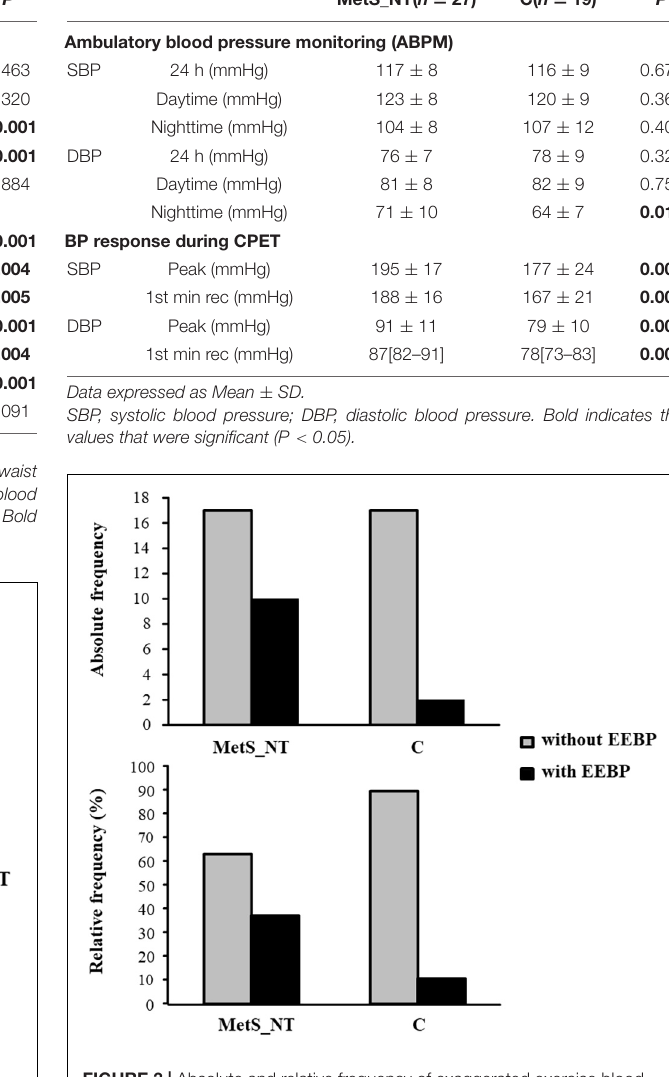
FIGURE 3 | Absolute and relative frequency of exaggerated exercise blood pressure (EEBP = peak exercise SBP ≥ 210 mmHg in men and ≥ 190 mmHg in women) response during maximal CPET in the MetS_NT and in C. Note that the prevalence was significantly lower in the C group ( P = 0.044).